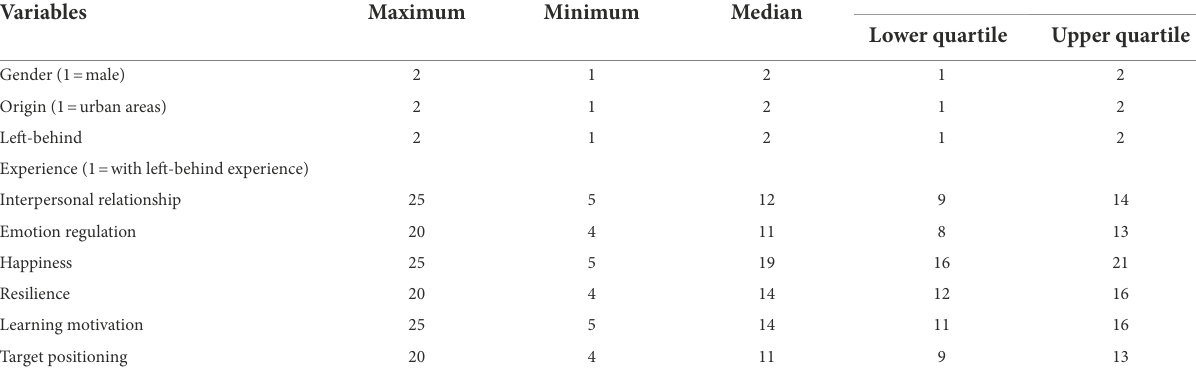
TABLE 2 Description statistics.